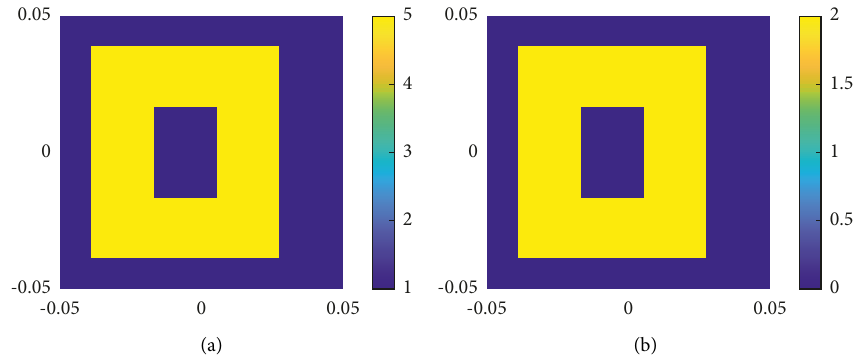
Figure 17: Relative permittivity distribution of ring scatterers. (a) Real part. (b) Imaginary